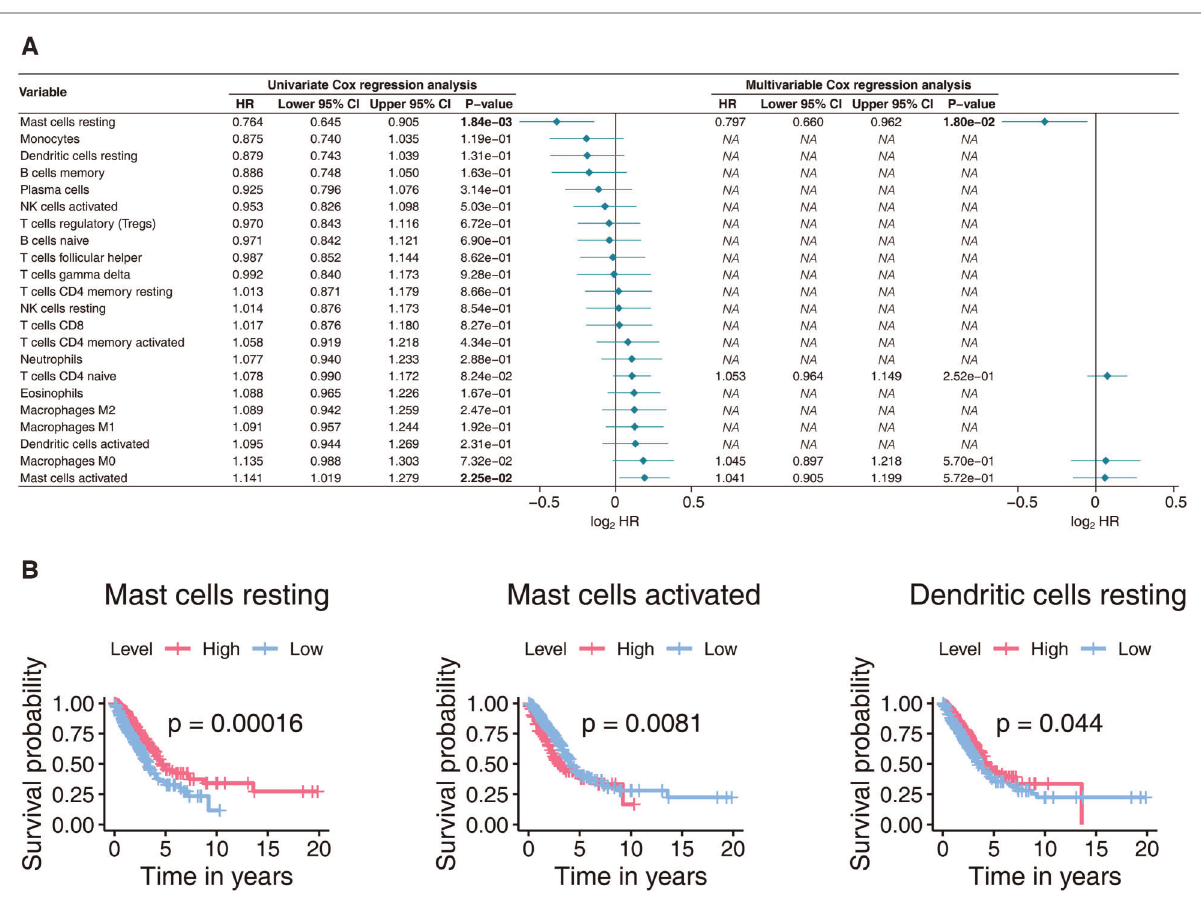
FIGURE 8 The prognostic power of the 22 TICs was determined using the Cox proportional hazards model ( A ) and the Kaplan-Meier estimator ( B ). In Panel A, only univariate variables with p -values less than 0.1 were included in the multivariable analysis, with bold text indicating p -values<0.05. In Panel B, we only show Kaplan-Meier plots with p -values less than 0.05. TIC, tumor-in fi ltrating immune cell; p -value<0.05 is considered signi fi